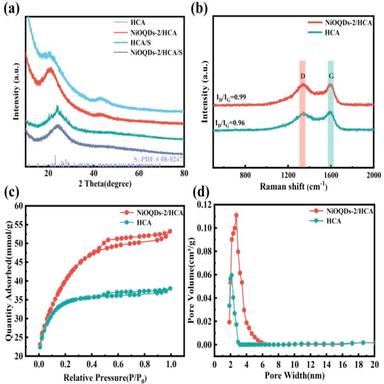
(a) XRD patterns of HCA, NiOQDs-2/HCA and HCA/S,NiOQDs-2/HCA/S; (b) Raman patterns of NiOQDs-2/HCA and HCA; (c) N2 adsorption/desorption isotherm and (d) pore size distributions.